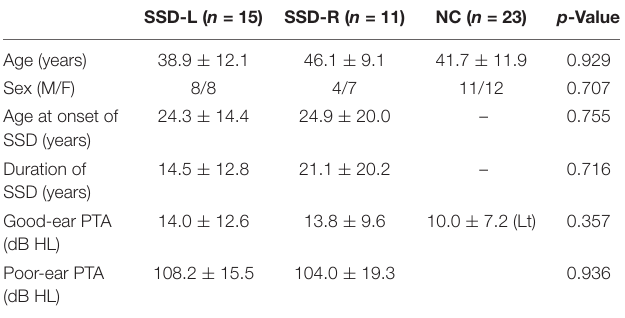
TABLE 1 | Demographic characteristics of the groups.